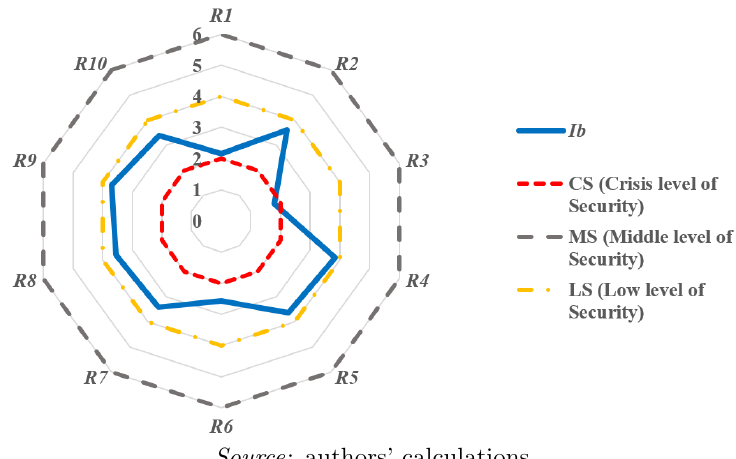
Figure 1: The level of economic security of the regions of